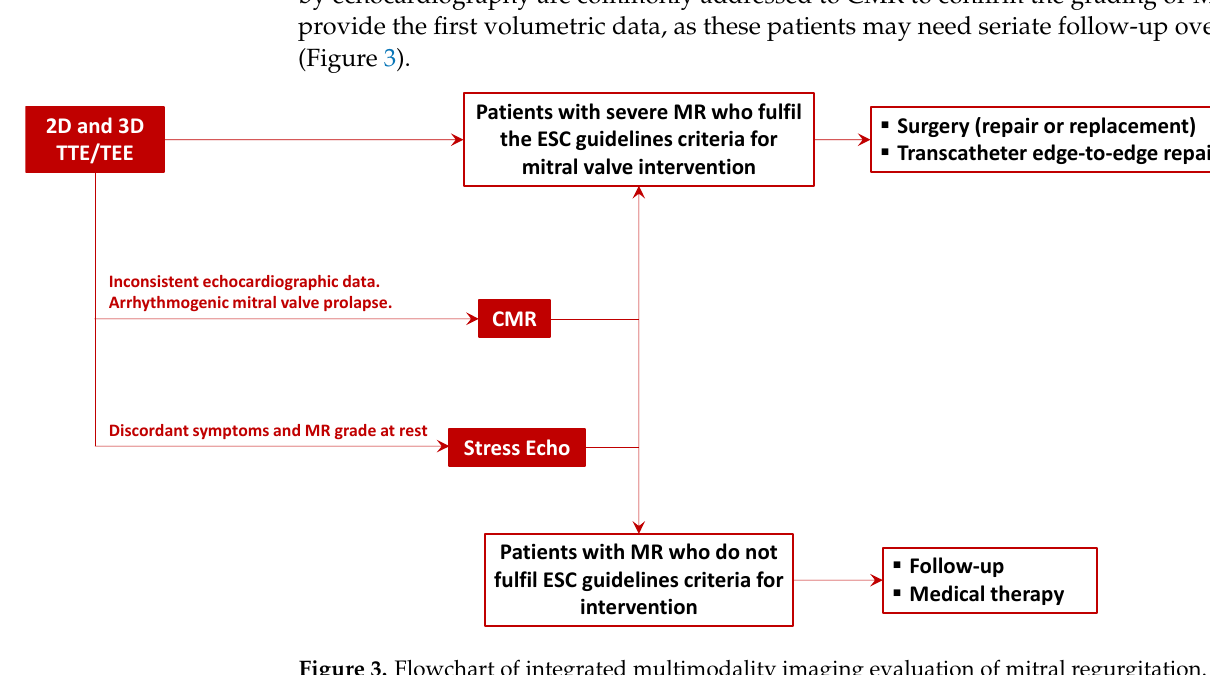
Figure 3. Flowchart of integrated multimodality imaging evaluation of mitral regurgitation.